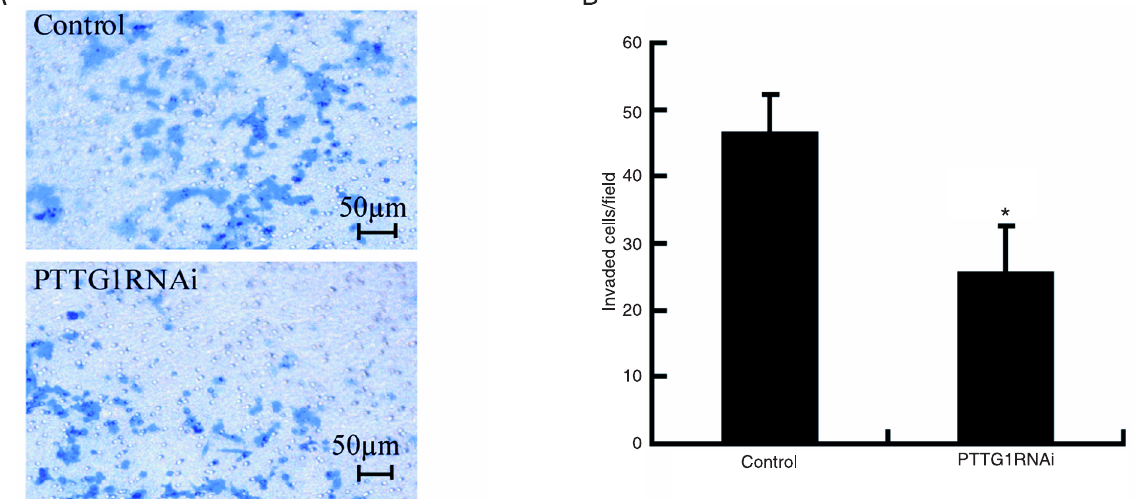
Figure 4. Pituitary tumor-transforming gene-1 (PTTG1) knockdown reduced invasive capacity as revealed by a transwell invasion assay. A , A significantly greater number of cells (stained blue) were observed on the underside of the Matrigel in transwell assays of control cultures than in transwell assays of PTTG1RNAi cultures. B , Quantification of the numbers of PTTG1RNAi and control PC3 cells migrating through the Matrigel. *P < 0.05 compared to control (Student t